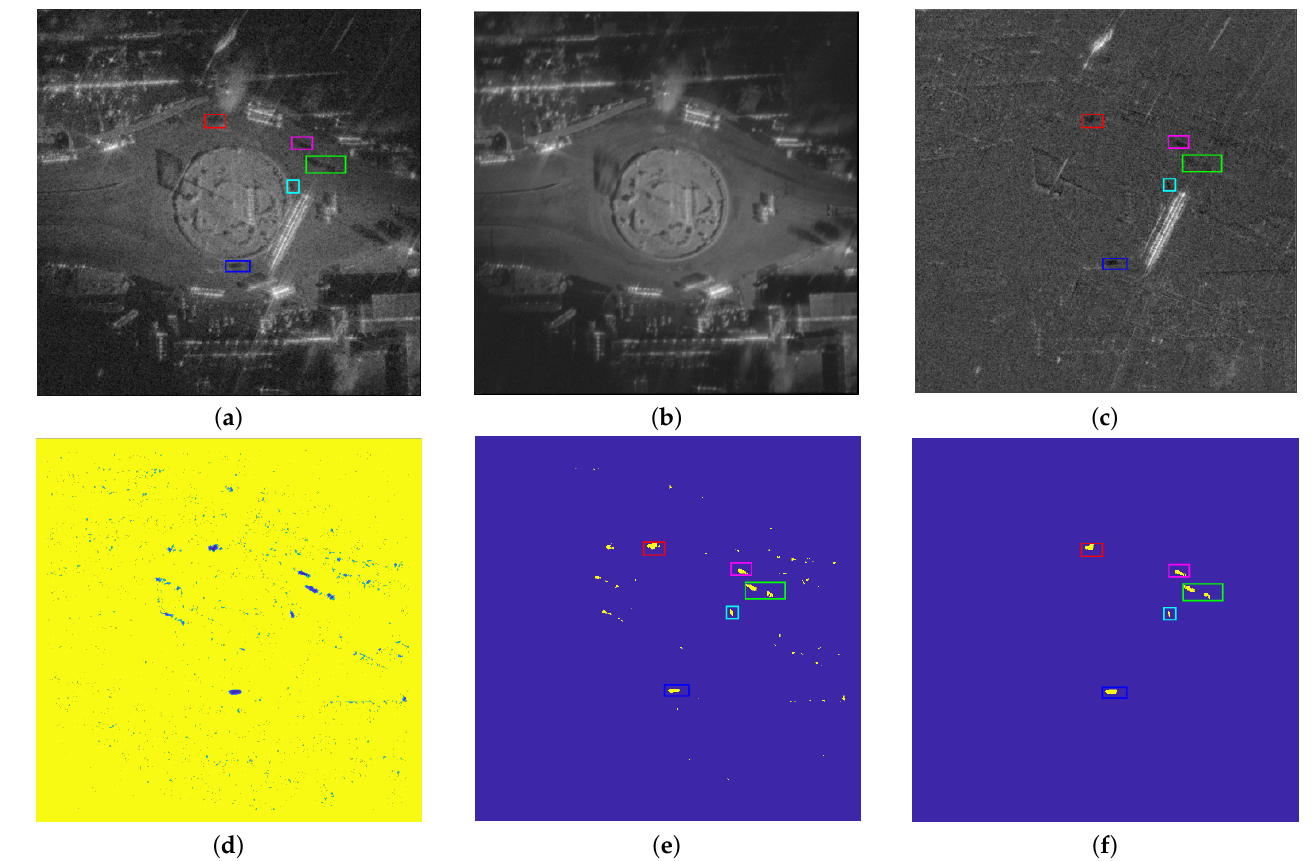
Figure 7. Results of 17th image in different steps of the proposed moving target shadow detection framework. ( a – c ) The initial image, the corresponding background, and the foreground, respectively. ( d ) The multi-scale neighborhood similarity map. ( e ) The detection results of the BIIANS method. ( f ) The final detection